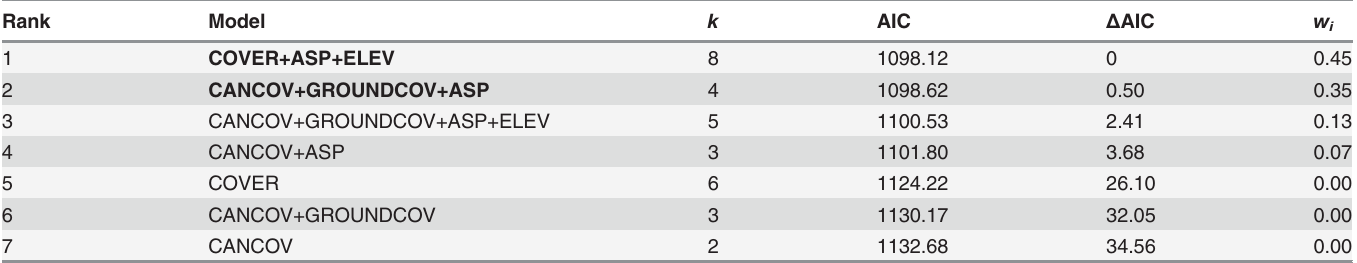
Included are the number of estimated parameters ( k ), Akaike ’ s information criterion (AIC), Akaike ’ s information criterion differences ( Δ AIC), and Akaike weights ( w i ). Models retained for statistical inference are in